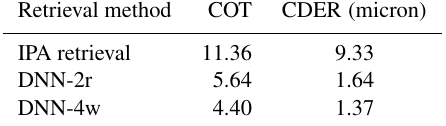
Table 1. The RMSE of estimated COT and CDER by the IPA re- trieval and DNNs for a view zenith angle of 0 ◦ at y = 14.56km in Fig. 5. Retrieval